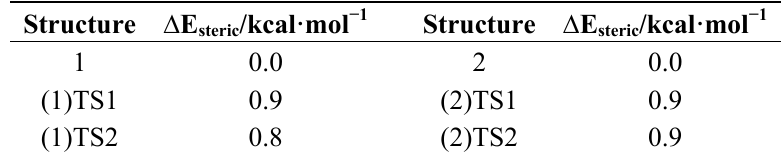
Table 7. Relative NBO Steric Exchange Energies between oxygen and nitrogen lone